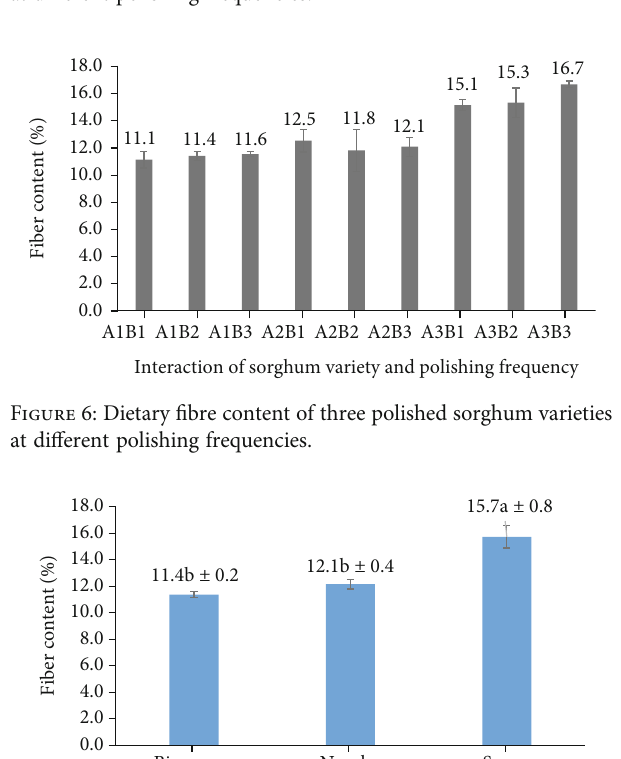
Figure 5: Antioxidant capacity of three polished sorghum varieties at di ff erent polishing frequencies.